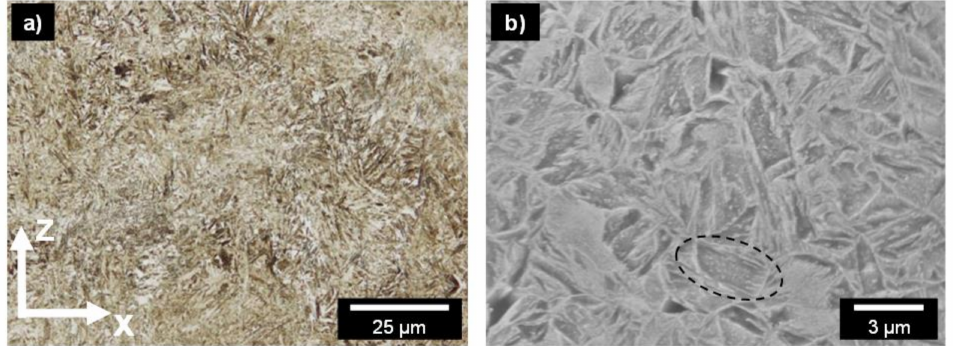
Figure 7. Details of the 0.8 wt.% C specimen in the as-built state, ( a ) light microscope image revealing fine martensite and retained austenite ( b ) SEM image showing carbides; z indicates the build